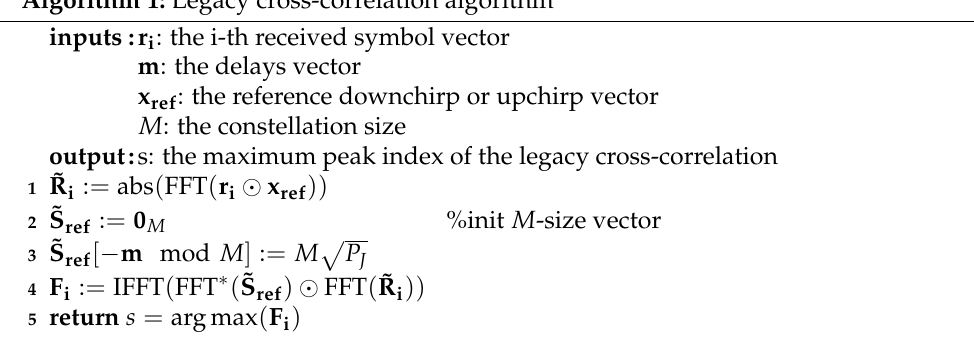
Algorithm 1: Legacy cross-correlation